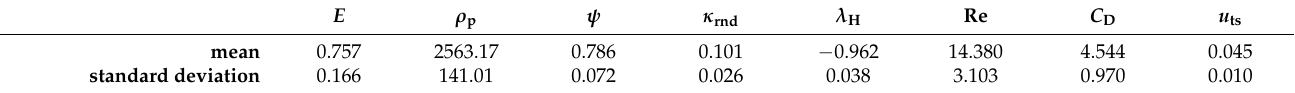
Table A5. Mean values and standard deviations for the parameters relevant to the calculated models.